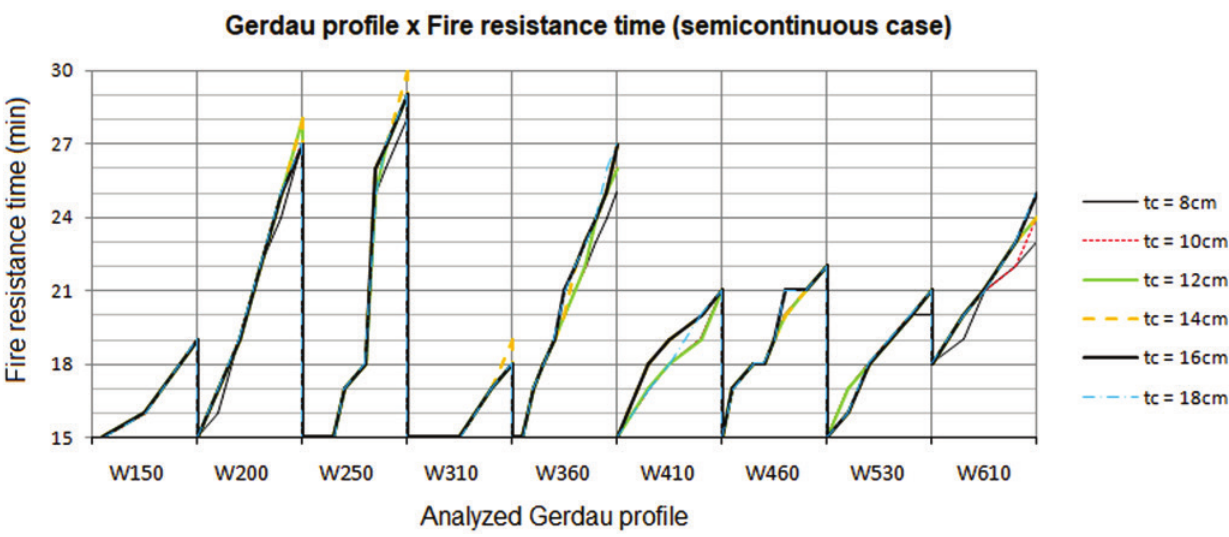
Figure 6 Semi-continuous case fire resistance time (for 0.7 load factor) as function of the analyzed profile